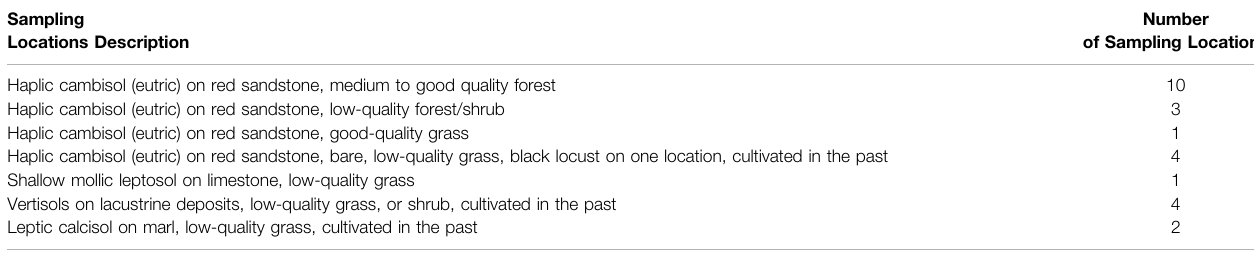
TABLE 2 | Concise description of the sampling